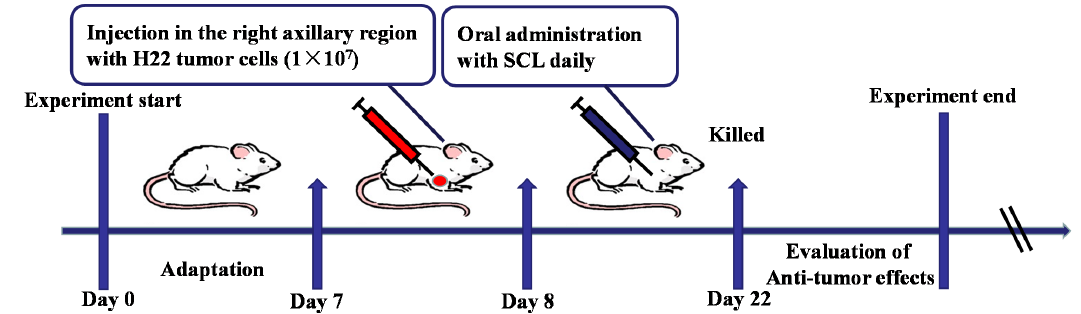
Figure 1. Experiment design scheme. To establish the murine solid tumor H22 transplanted model, mice were subcutaneously injected with H22 tumor cells. Twenty four hours after tumor cell injection, two doses of steamed C . lanceolata (SCL) (200 and 400 mg/kg) were administered daily for 14 days. At the end of the experiment, all mice were sacrificed to evaluate the anti-tumor efficacy. n =